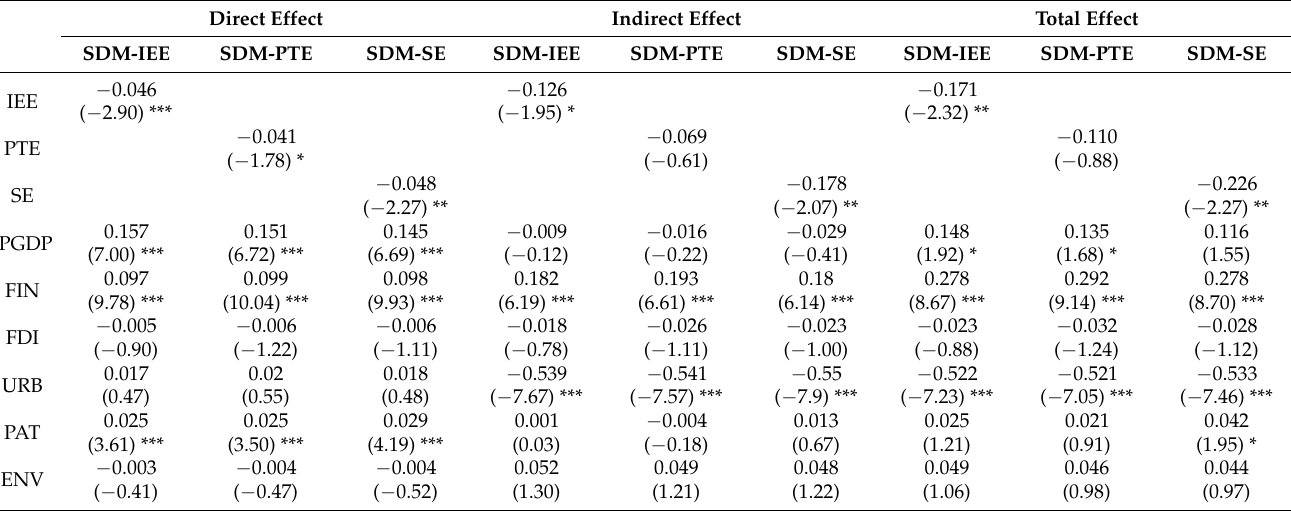
Table 4. Direct, indirect, and total effects of spatial Durbin